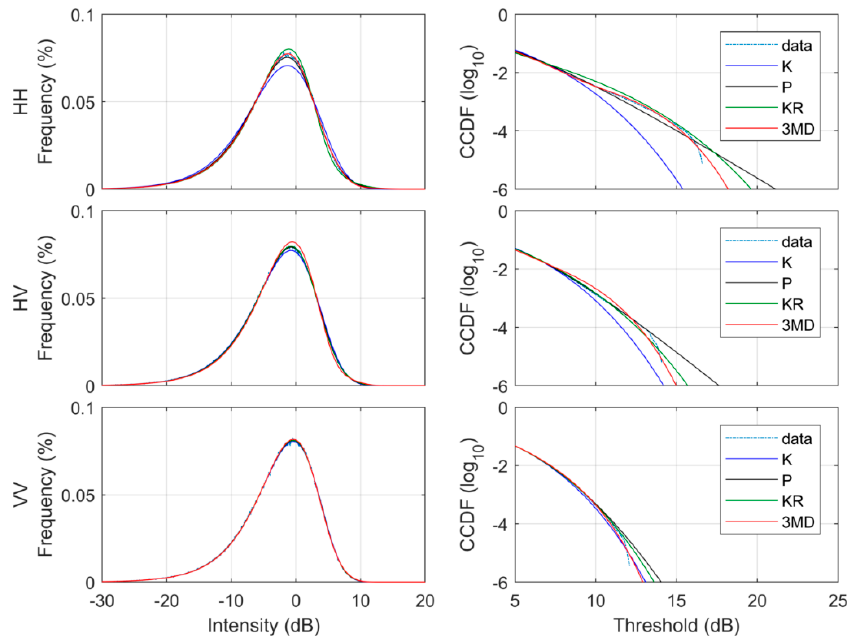
Figure 12. Amplitude distributions for the INGARA dataset (Run 3), upwind, grazing angle 30°. Illustrations show the ( left ) PDF and ( right ) CCDF results. Table 7. Parameter estimates for the model fits in Figure 12.